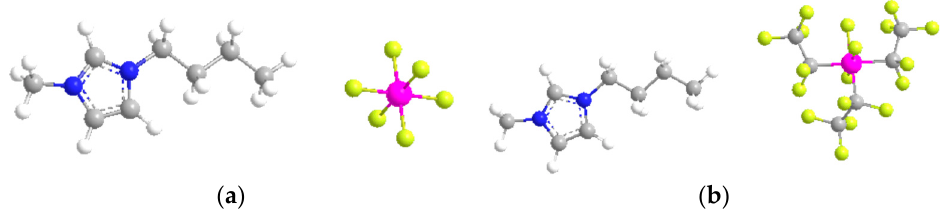
Figure 1. Schematic structure representation of ( a ) 1 ‐ butyl ‐ 3 ‐ methylimidazolium hexafluorophosphate, [bmim][PF 6 ], and ( b ) 1 ‐ butyl ‐ 3 ‐ methylimidazolium tris(pentafluoroethyl) trifluorophosphate, [bmim][FAP].